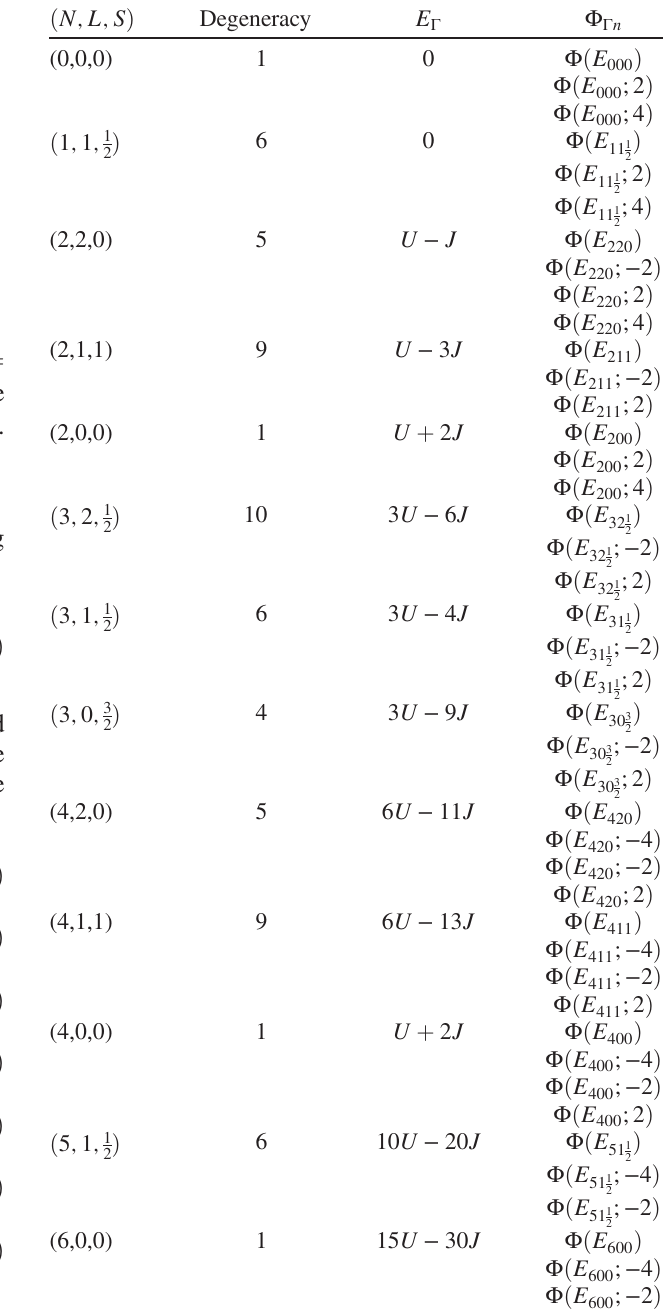
TABLE I. Quantum numbers ð N; L; S Þ , degeneracy, eigenval- ues, and the corresponding slave bosons Φ ð E Γ ; 2 q Þ for each local multiplet j Γ i